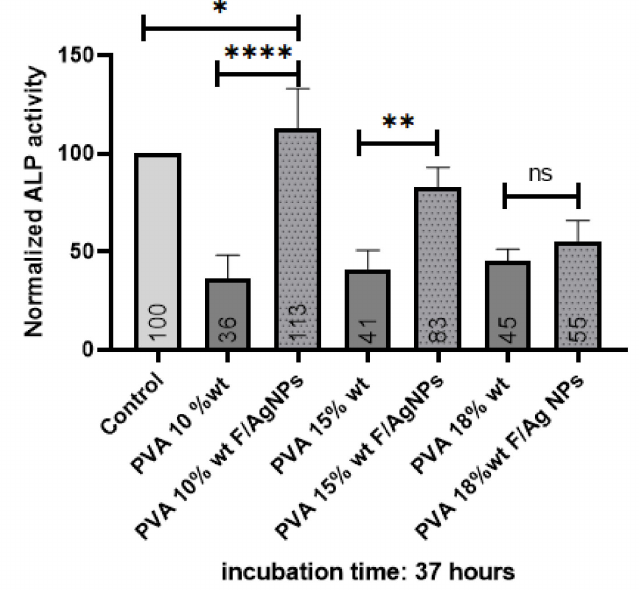
Figure 11. Alkaline phosphatase of MG-63 cells after 37 h of culture with PVA membranes. Statistical analysis was developed with ordinary one-way ANOVA followed by Tukey’s multiple comparisons test, p < 0.05. * Low significant difference, ** Significant difference, **** High significant difference, ns No significant